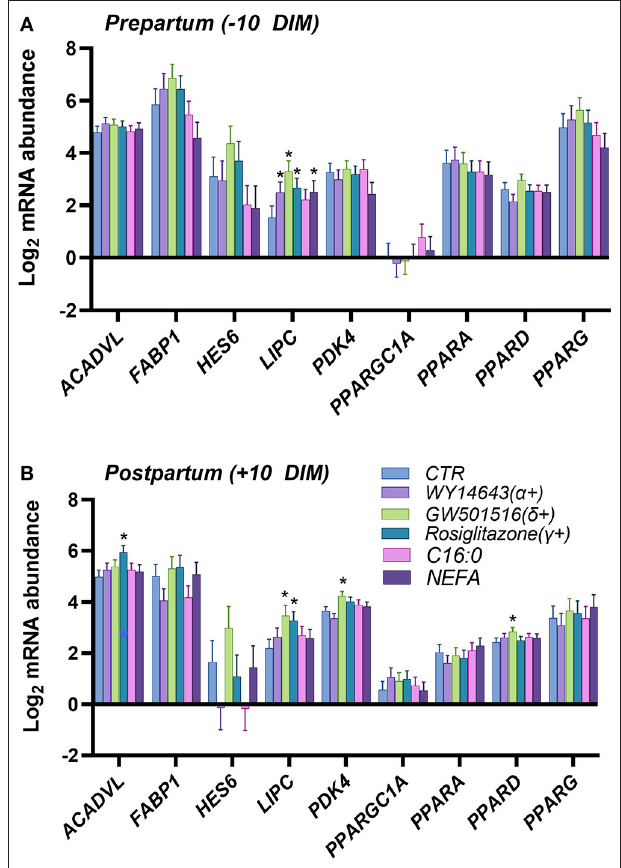
FIGURE 1 | Relative normalized expression of ACADVL, FABP1, HES6, LIPC, PDK4, PGC1A, PPARA, PPARD and PPARG in response to synthetic PPAR agonists (100 µ M WY-14643, a PPAR α agonist; 50 µ M GW-501516, a PPAR δ agonist; and 100 µ M Rosiglitazone, a PPAR γ agonist), 200 µ M palmitic acid, or 100 µ M NEFA isolated from each respective animal, in PCLS obtained from prepartum [ (A) , − 10 DIM] and postpartum [ (B) , + 10 DIM] cows, and cultured for 18h in William’s Medium E. *indicates significant differences ( P < 0.05) when compared to WME